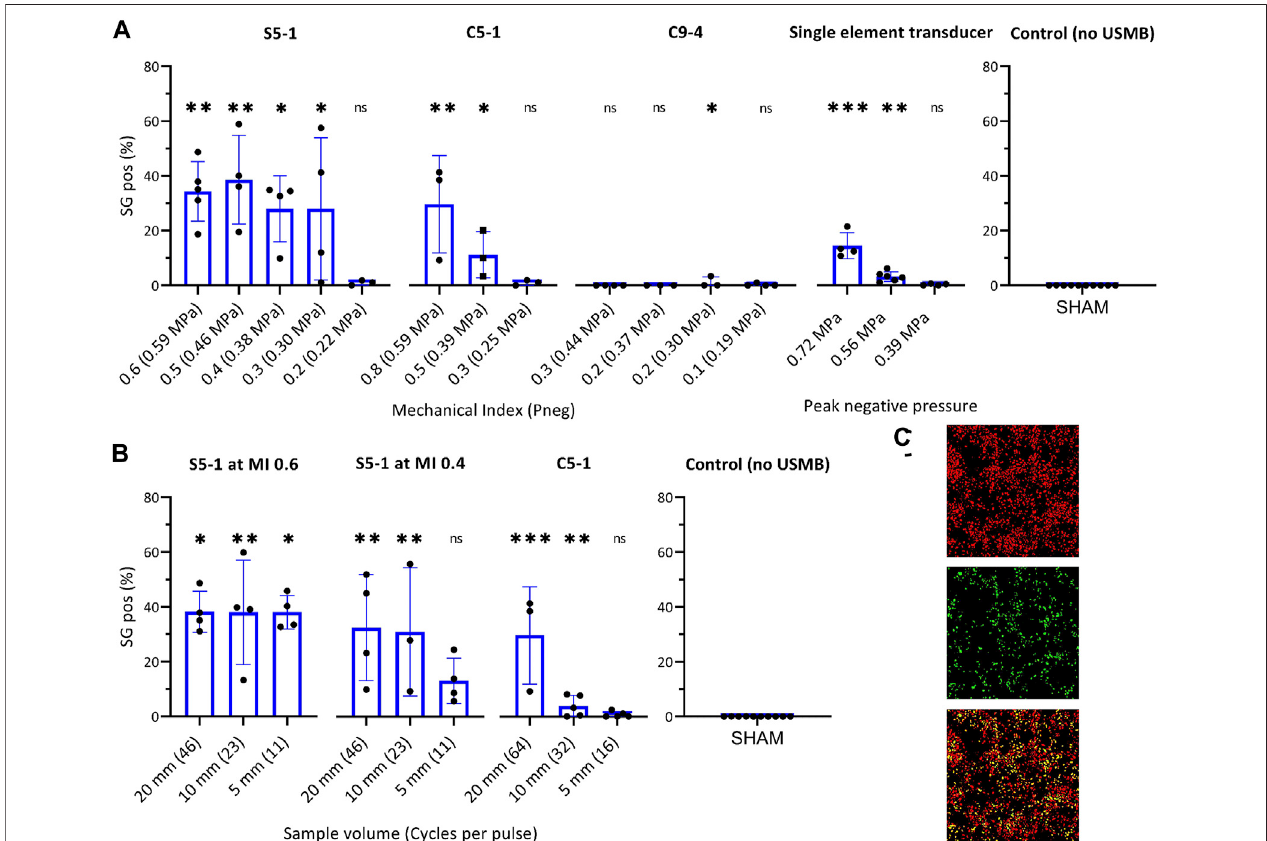
FIGURE 4 | Effect of transducer and ultrasound settings on USMB ef fi ciency measured by percentage SG positive cells in ROI. (A) Effect of pressure on USMB ef fi ciencywith(fromlefttoright)clinicalUSsystemwithS5-1,C5-1 orC9-4 probeandcustom-build USset-up withsingle-elementtransducer. (B) Effect ofpulse length onUSMBef fi ciencyofclinicalUSsystemwith(fromlefttoright)S5-1probeatmaximumpressure(MI0.6,P neg 0.59 MPa),S5-1probeatMI0.4(P neg 0.38 MPa)andC5- 1probeatmaximumpressure(MI0.8,P neg 0.59 MPa).SymbolsindicateindividualmeasurementsandbarsindicatemeanandSD( n ≥ 3)Allvalueswerestatistically compared to USMB untreated samples (right). * p < 0.05 ** p < 0.01 *** p < 0.001. (C) Representative fl uorescence images of ROI after USMB with S5-1 probe at MI 0.6 (0.59 MPa) and maximum pulse length (SV 20 mm). Top: DRAQ5 ™ staining, middle: SG staining, Bottom: composite, cells stained for DRAQ5 ™ (red), SG (green) or both (yellow). SG uptake in 35.1% of cells. ns: not signi fi cant; SG: SYTOX ™ Green; USMB: ultrasound and